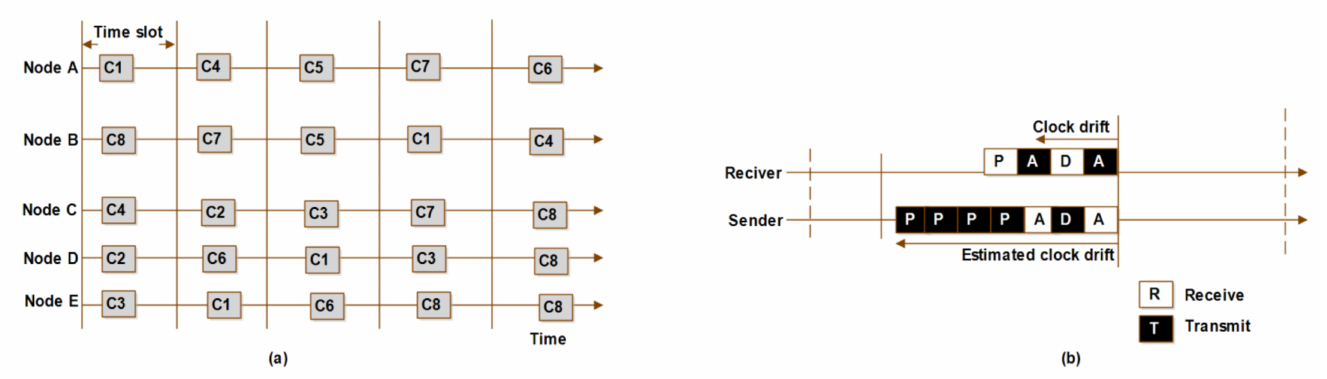
Figure 9. ( a ) Channel selection. ( b ) Preamble based communication of a